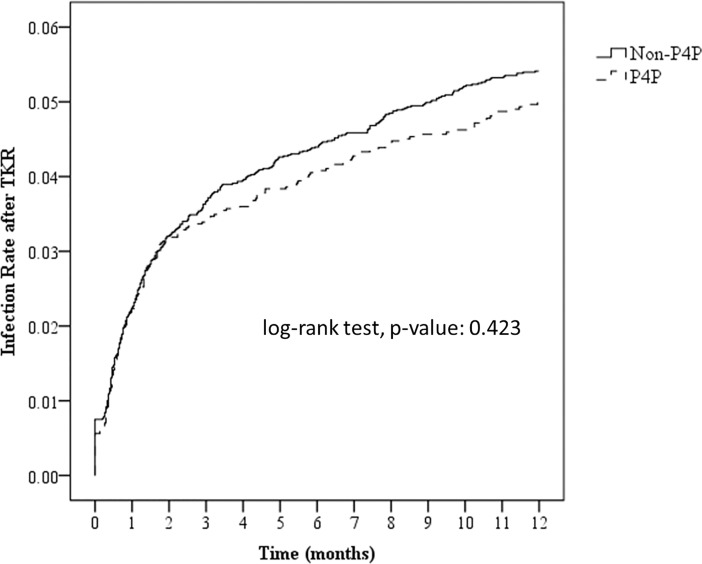
Cumulative risk curves of TKA postoperative infection for P4P and non-P4P patients.Joining the P4P program is associated with a tendency of lowered risk, but this result is not statistically significant (p = 0.423).